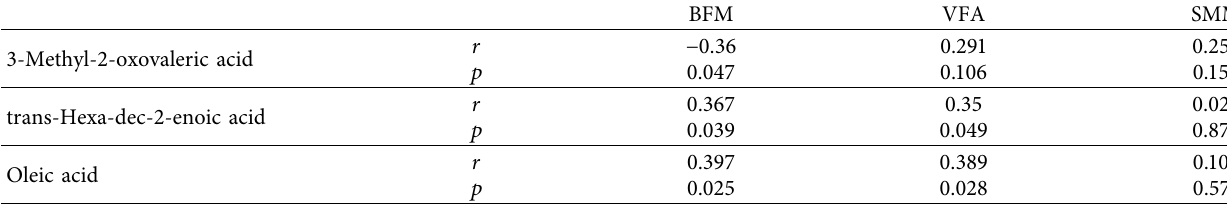
Table 8: Correlation between metabolites and body